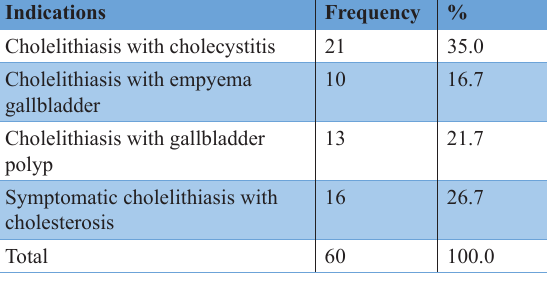
Table 1. Preoperative indications for putting an abdominal drain in elective LC in patients with